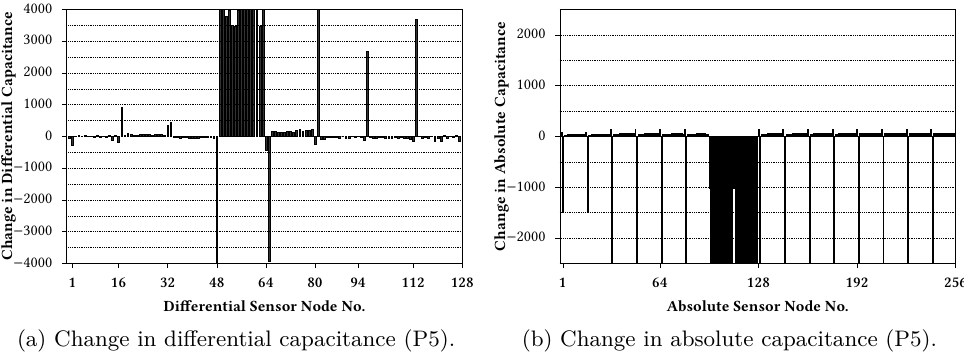
Figure 21: Attack Profile 5 (P5): result of a single hole of 0 . 33 mm in diameter, severing electrode Tx7, Tx8, and Rx2. Due to having a single hole is the cut-off of Tx7 and Tx8 considered